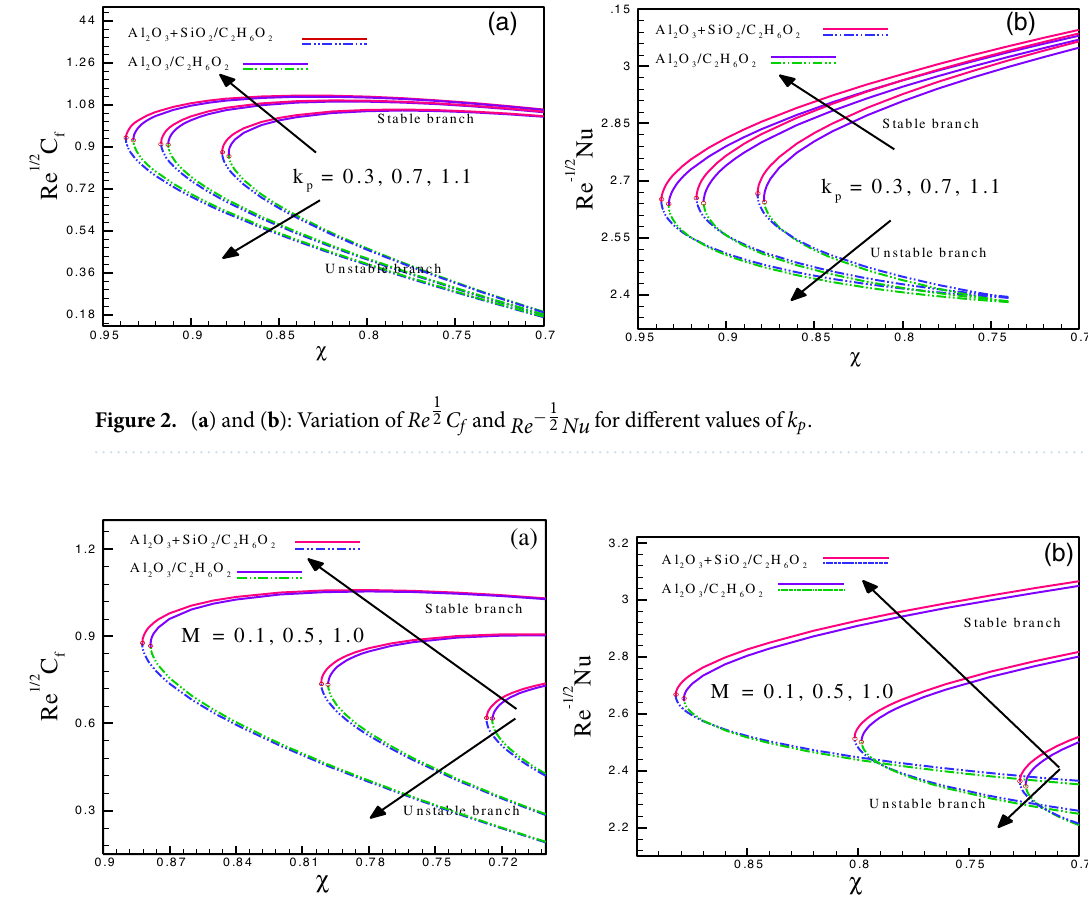
1 1 2 C f and Re − 2 Nu for different values of M